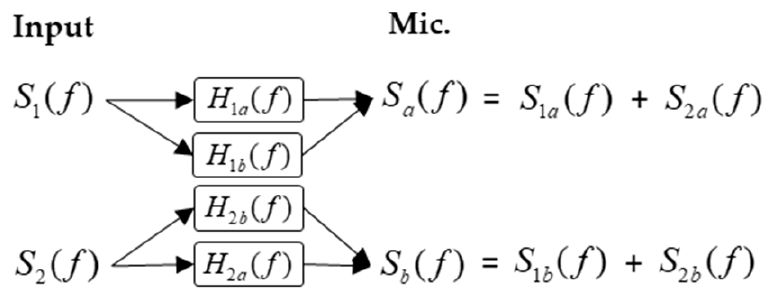
Figure 2. Measurement interference model for the two-input/single-output system.